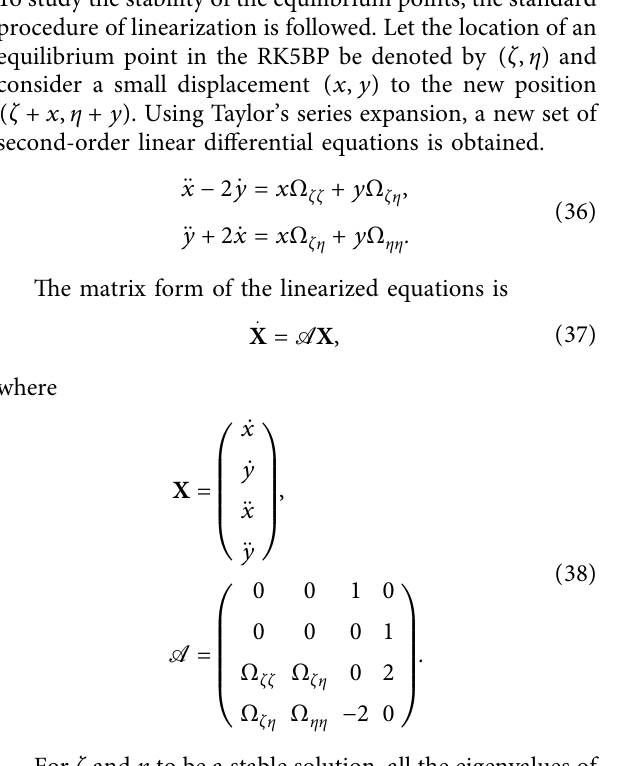
i represents so-